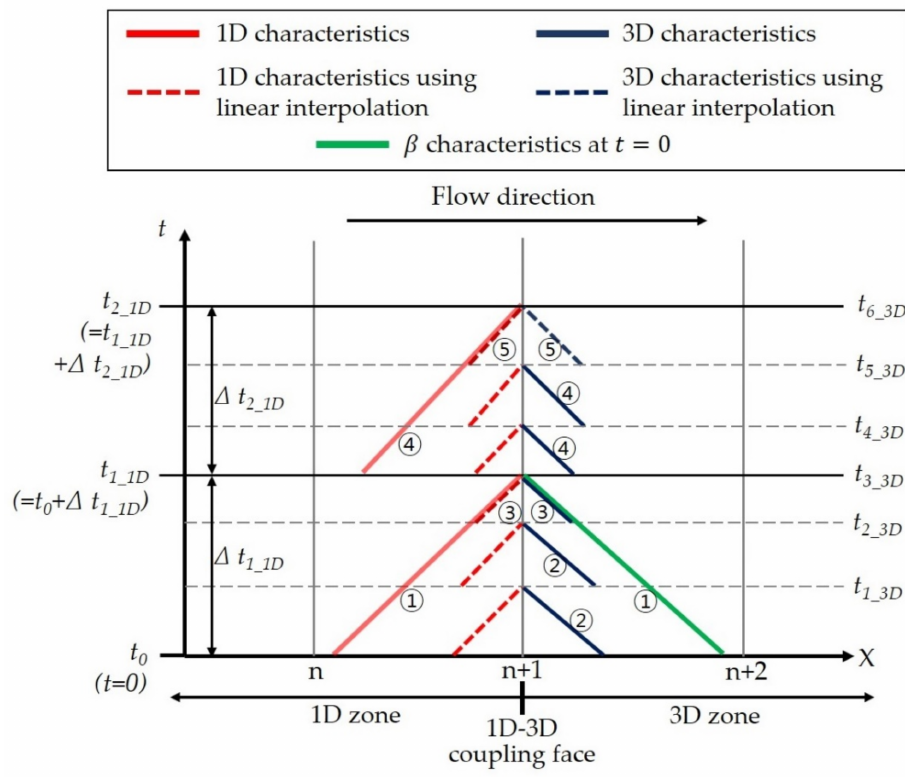
Figure 5. Synchronization process of time step size between 1D and 3D